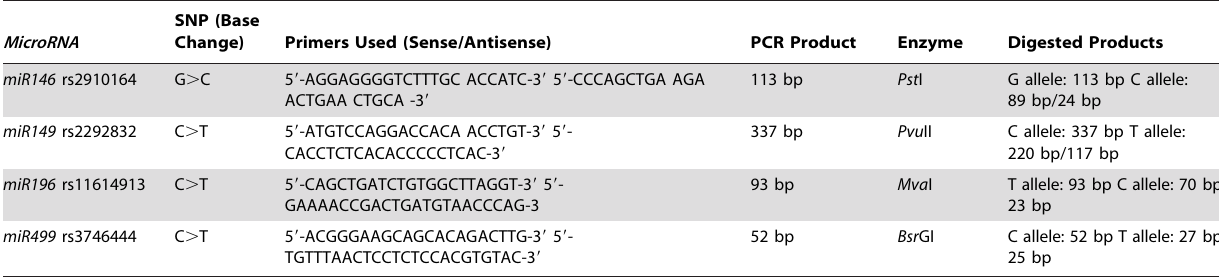
Table 1. Genotyping Assays of MicroRNA